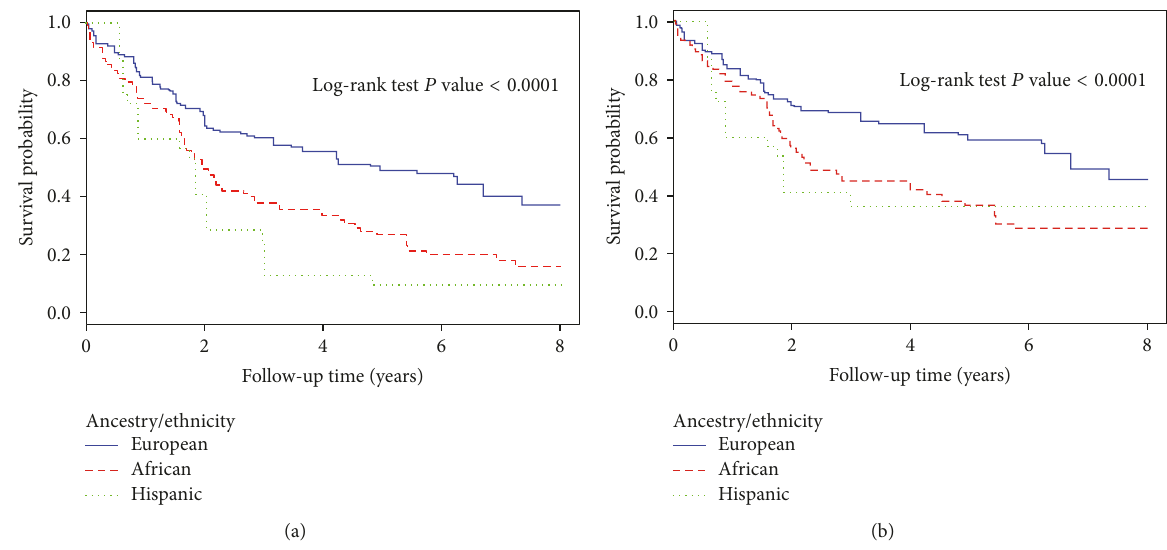
Figure 1: All-cause overall survival (a) and breast cancer-related survival (b) among inflammatory breast cancer patients based on race and ethnicity, Patterns of Care,